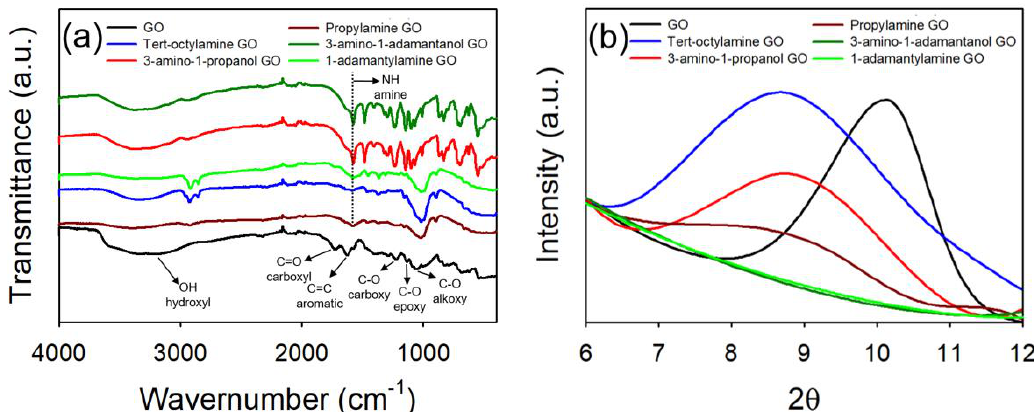
Figure 2. ( a ) FTIR spectra and ( b ) the diffraction patterns of GO (black), propylamine GO (dark red), tert-octylamine GO (blue), 1-adamantylamine GO (green), 3-amino-1-propanol GO (red), and 3-amino-a-adamatanol GO (dark green).